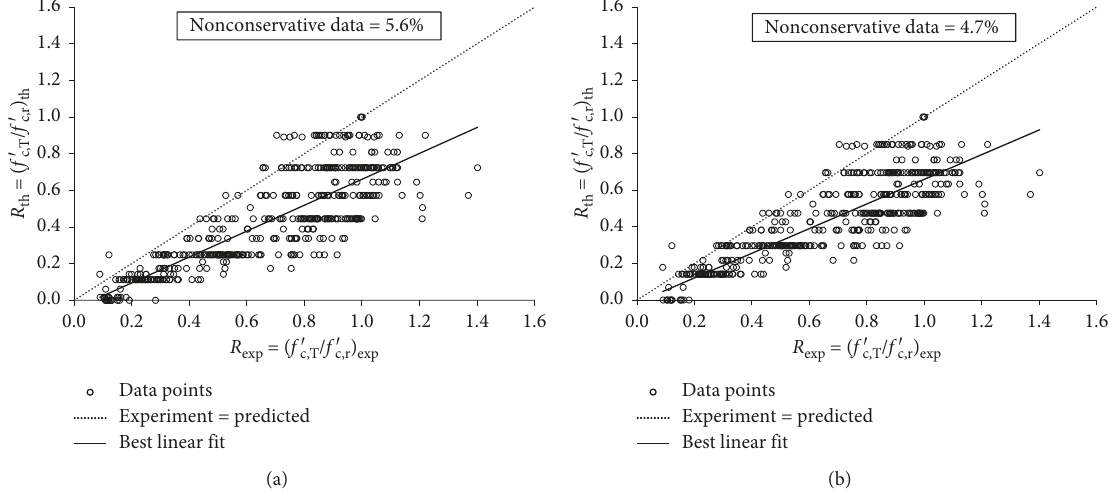
Figure 9: Comparison of normalized strength of HSC predicted by the proposed design models with experiment: (a) regression Model 5 and (b) regression Model